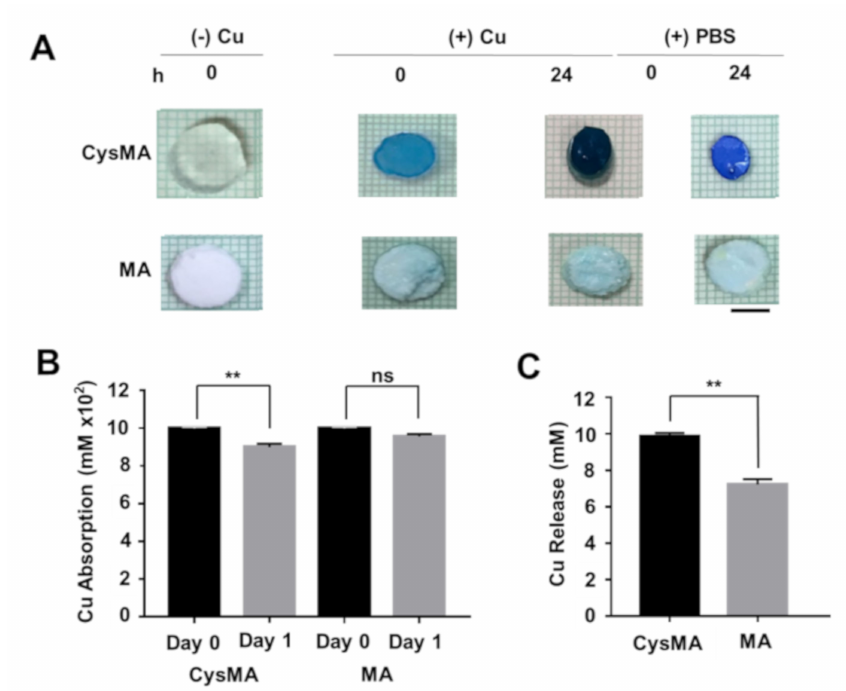
Figure 4. Copper ion absorption and release rate. ( A ) The hydrogels containing copper ions were soaked three times in 1 mL PBS to wash away free surface copper ions. The hydrogels were removed and placed in a new 1 mL PBS, and copper solution were measured ( B ). After 24 h, the hydrogels were removed and ( C ) the solution was measured using the calibration curve of OD value (620 nm). Bars = 0.5 cm. ** p < 0.01 (two-tailed t-tests). Data are the mean ± SD of three separate experiments. ns =